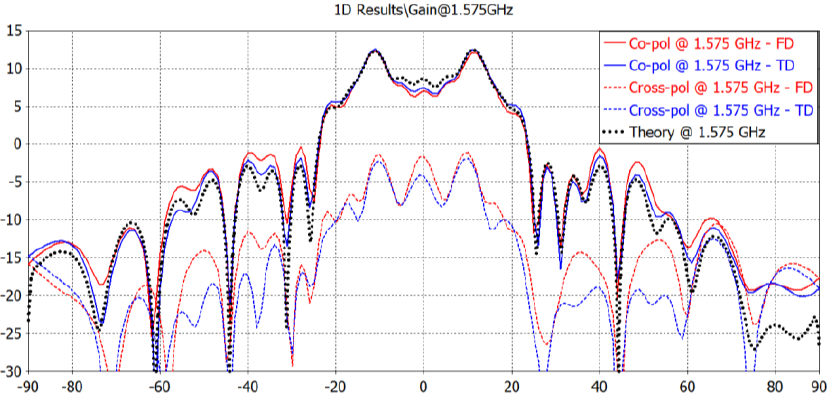
Figure 16. Design 2 – 16-element patch array: simulated gain at 1.575 GHz.